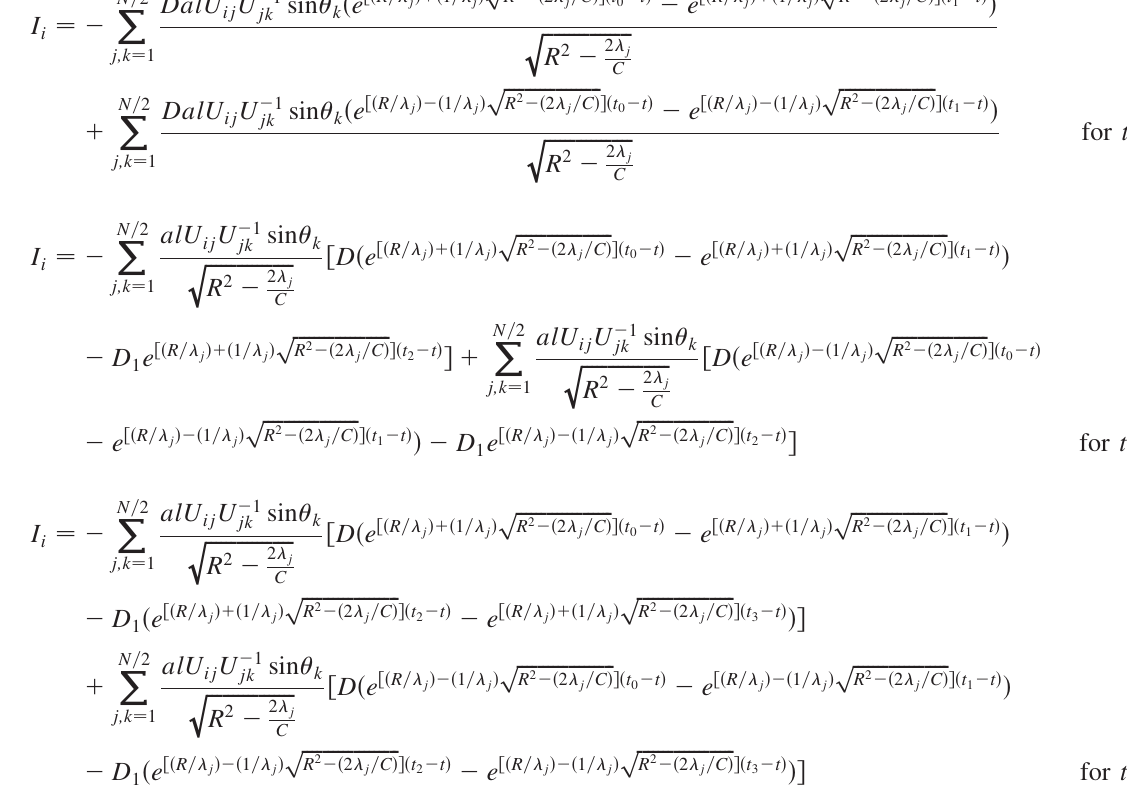
ffiffiffiffiffiffiffiffiffiffiffiffiffiffiffiffiffiffiffi p ffiffiffiffiffiffiffiffiffiffiffiffiffiffiffiffiffiffiffi R 2 (cid:1)ð 2 (cid:4) j =C Þ